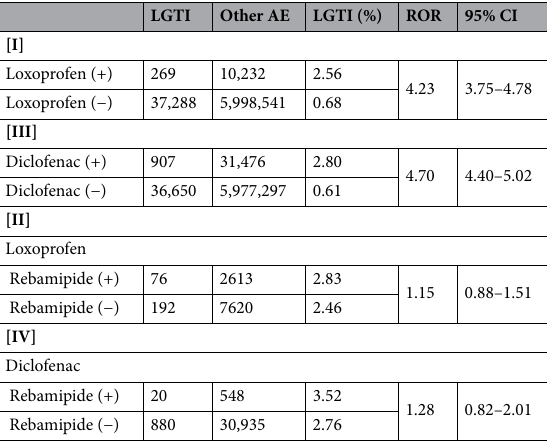
LGTI Other AE LGTI (%) ROR 95%